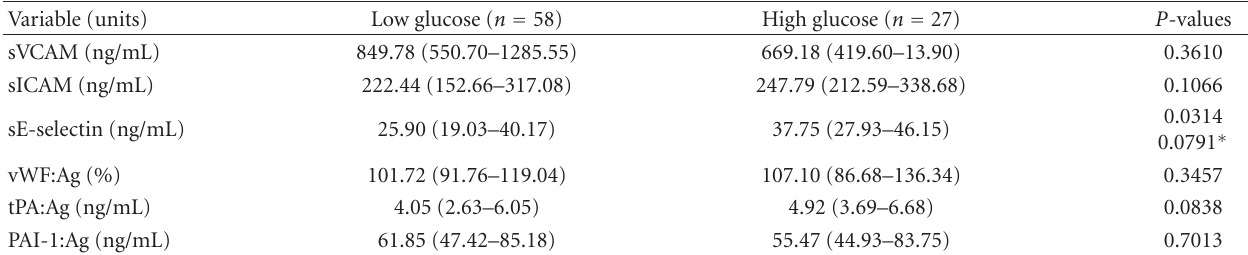
Table 3: Plasma concentrations of endothelium markers according to low and high-glucose concentration within the prediabetic range. Variable (units) Low glucose ( n = 58) High glucose ( n = 27) P -